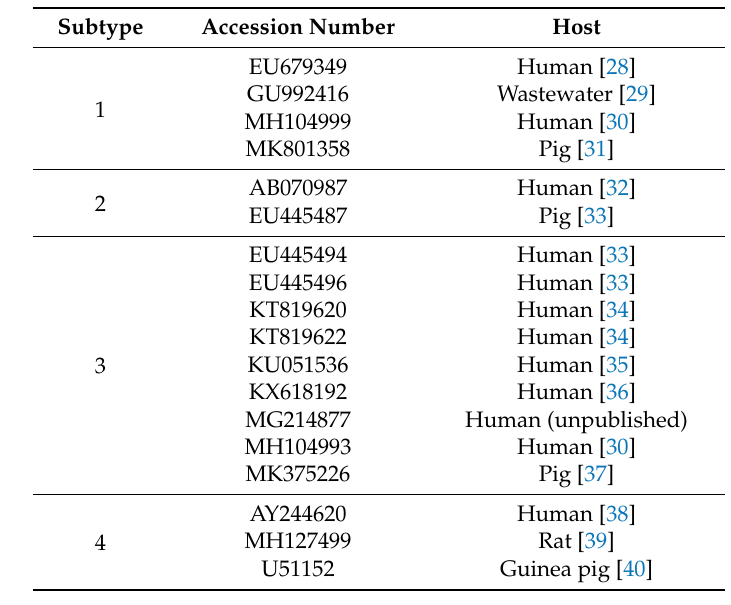
Table 1. GenBank references for the Blastocystis subtypes (ST)1–ST4 sequences used to construct a phylogenetic